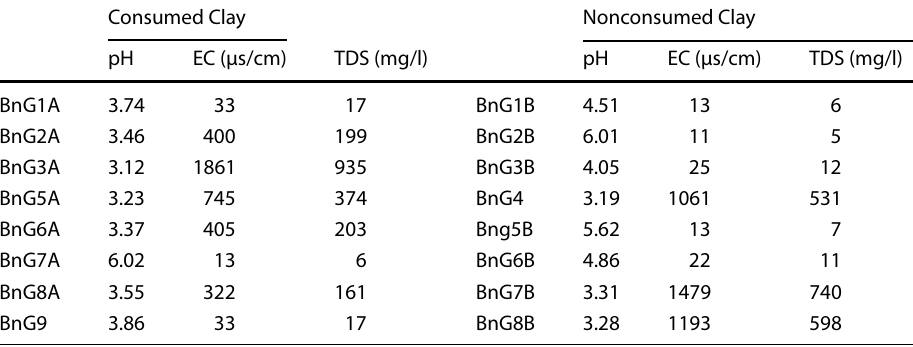
Table 1 Physicochemical properties of the clay in the study